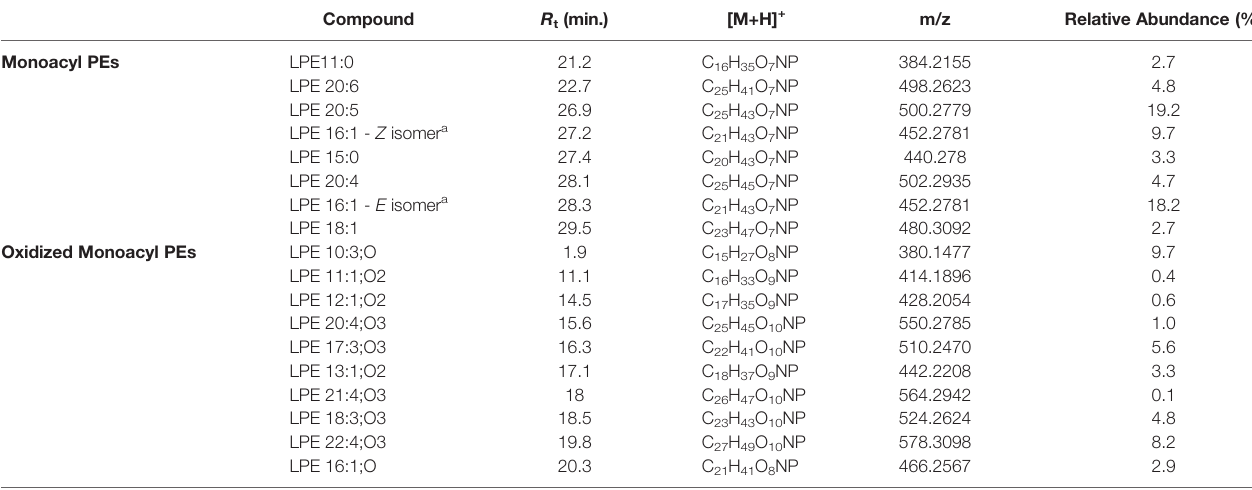
TABLE 3 | Lyso-phosphatidylethanolamines identi fi ed in the organic extract from Botrylloides niger . Compound